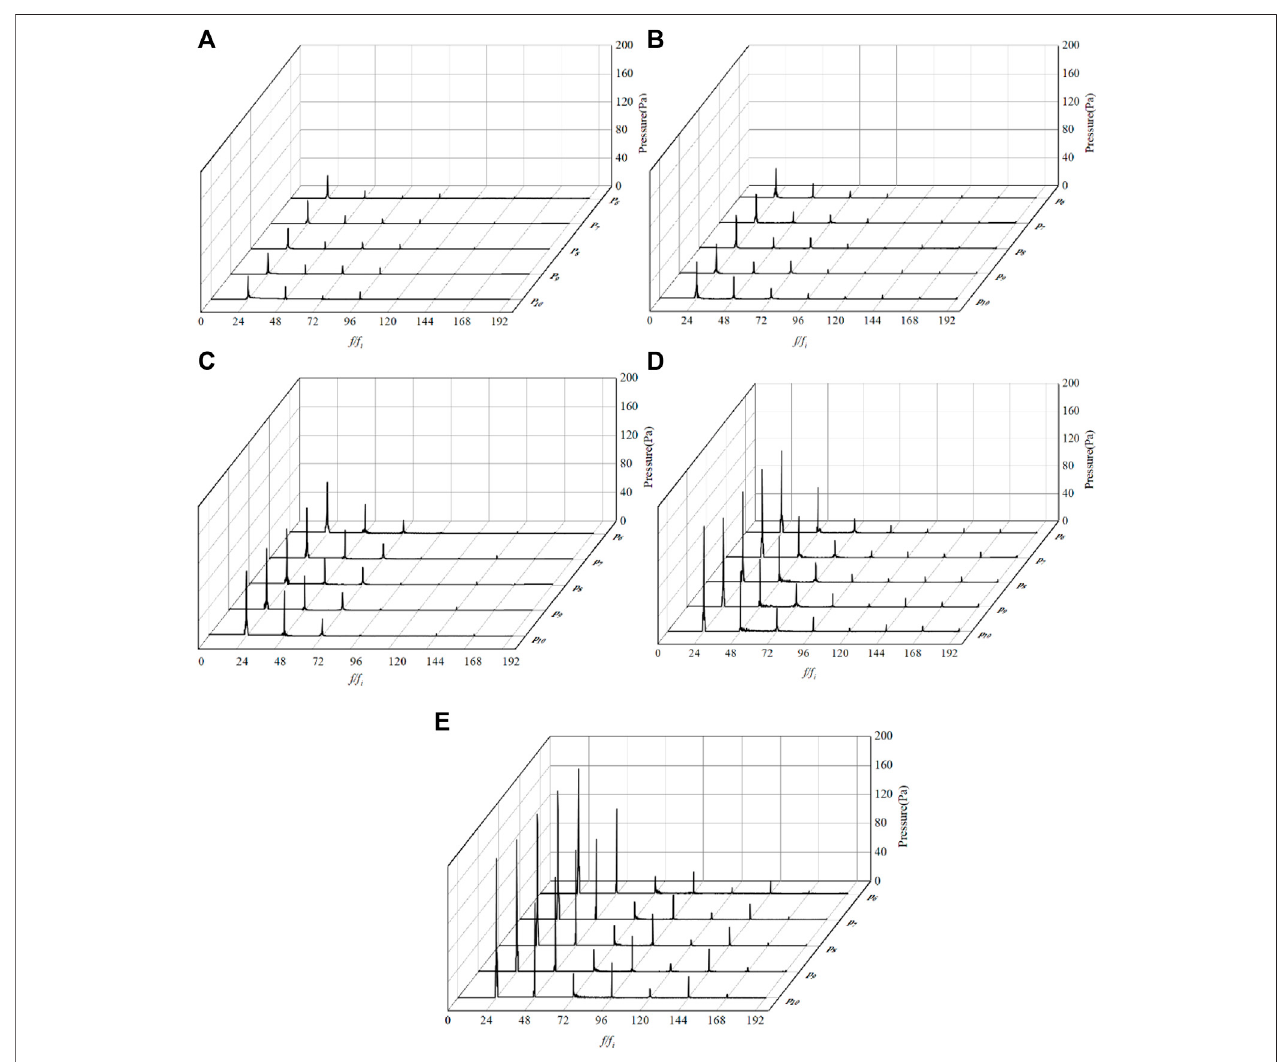
FIGURE15| Pressure fl uctuation spectrum ofP 6 -P 10 withdifferenthole diameters: (A) D 1 =11mm, (B) D 2 =13mm, (C) D 3 =15 mm, (D) D 4 = 17mm, and (E) D 5 =19 mm.